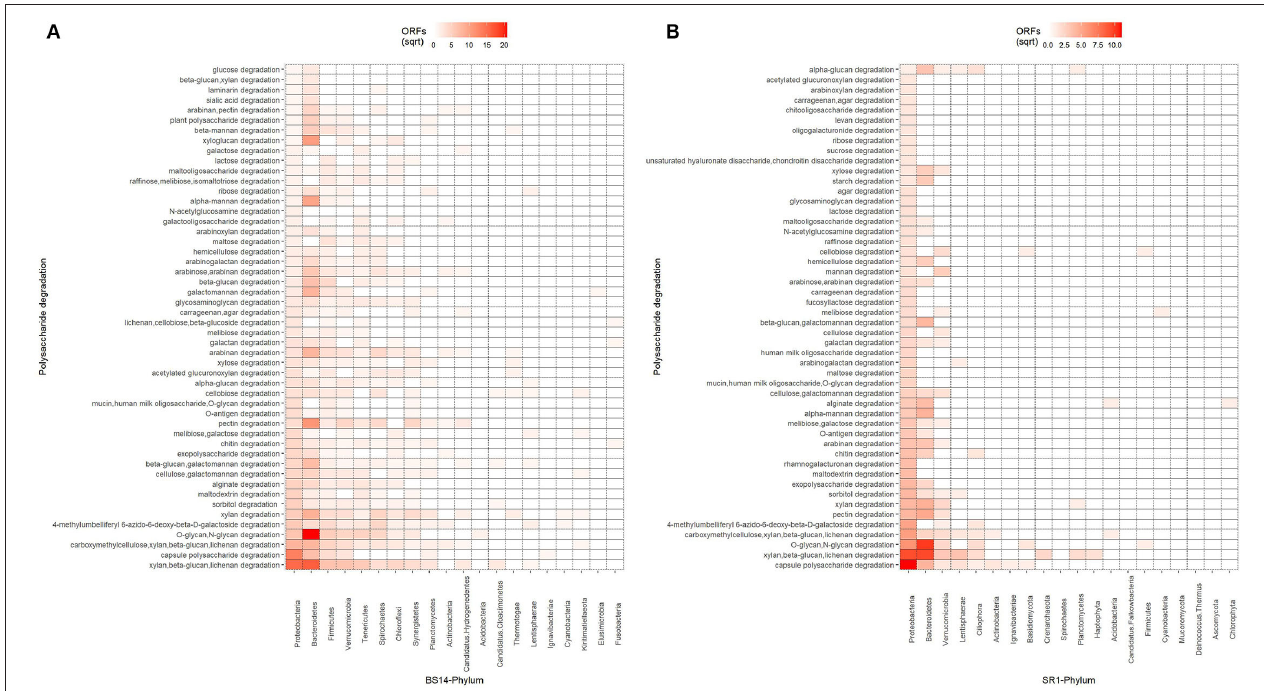
FIGURE 11 | Heatmap showing the distribution of polysaccharide metabolism of (A) BS14 and (B) SR1 at the phylum level.